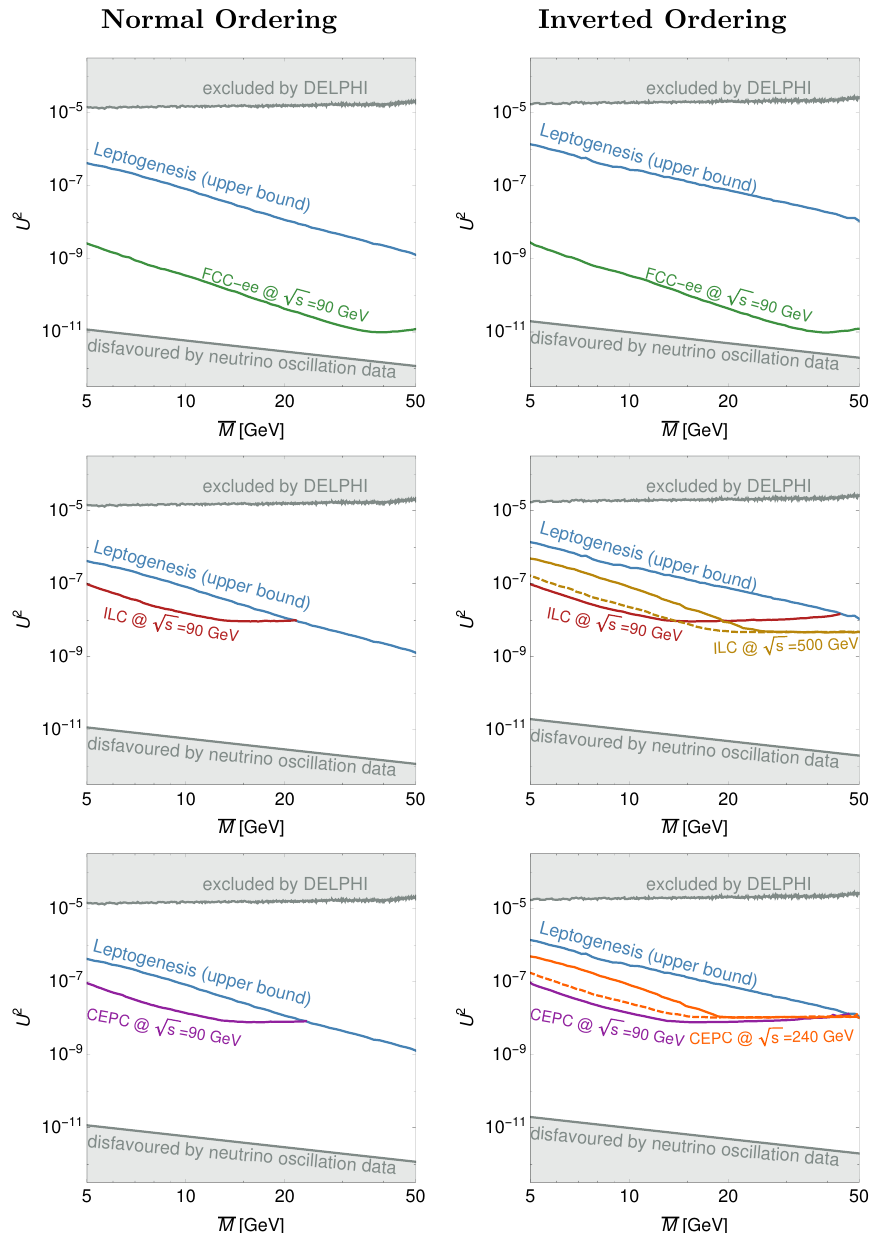
Figure 5 . The blue \BAU" line shows the largest possible U 2 for which the BAU can be generated for given (cid:22) M , as found in the parameter scan described in section 3.3. The other coloured lines mark the parameter regions in which future lepton colliders can observe at least four expected displaced vertex events from N i with properties that are consistent with successful leptogenesis. The solid and dashed lines correspond to the \guaranteed discovery area" and \potential discovery area" discussed in section 3.3. The grey area is disfavoured by DELPHI (on the top) and the neutrino oscillation data (at the bottom). We show no lower bound on U 2 from leptogenesis because it is lower than the constraint from neutrino oscillation data in this mass range. More details are given in the main text, cf. section 5.1.